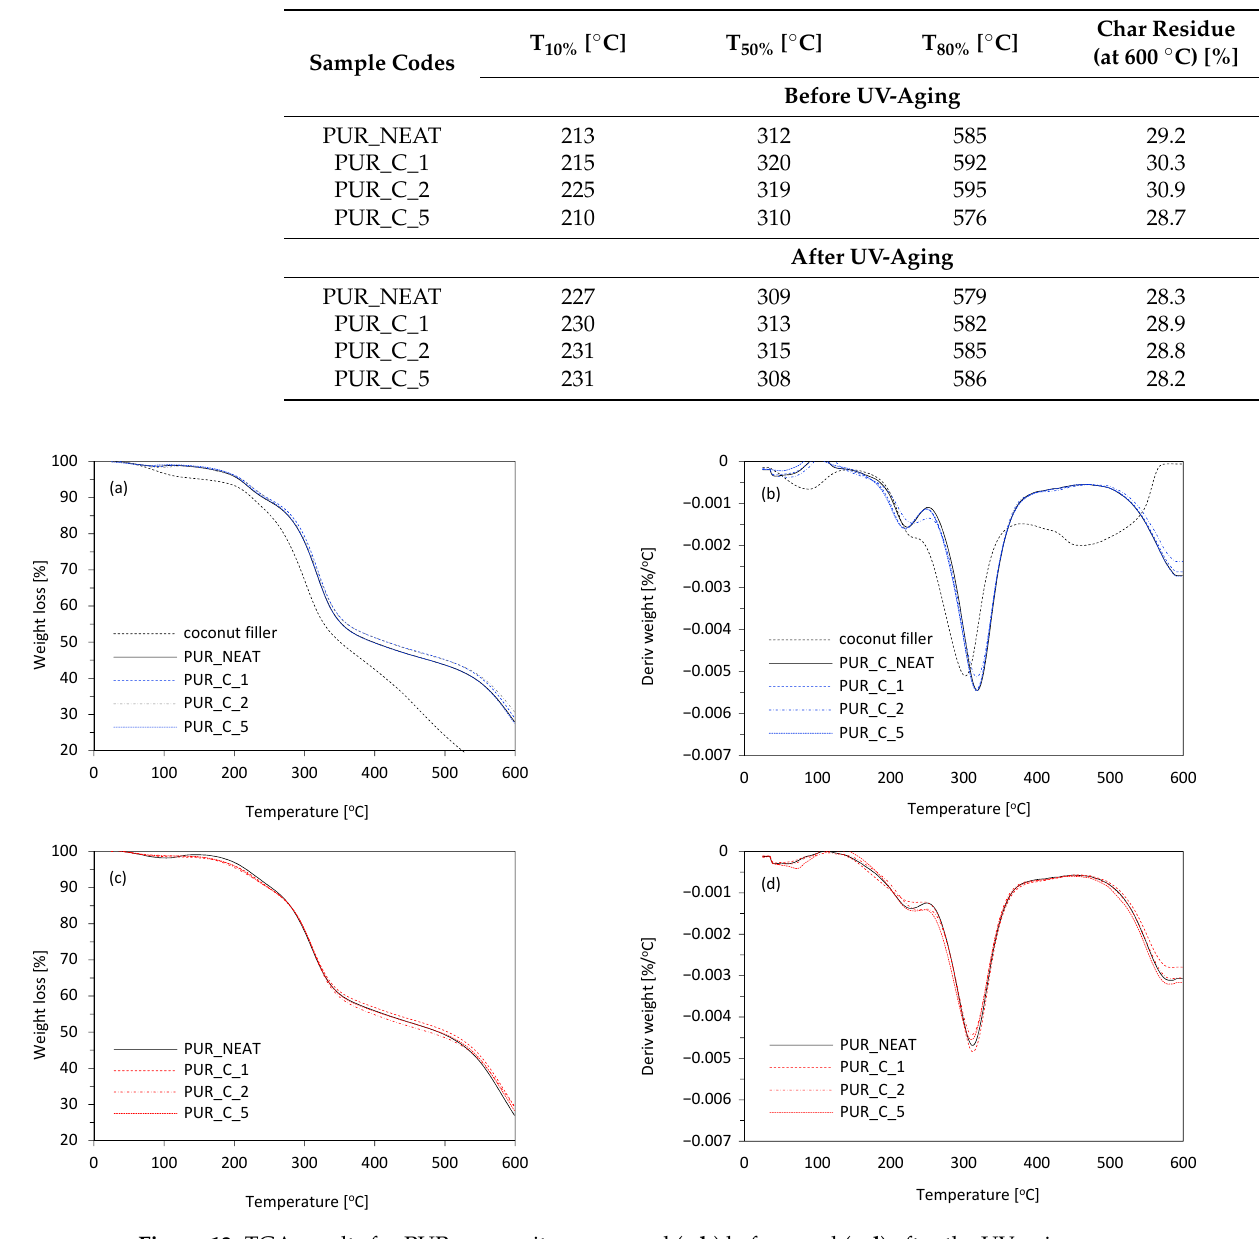
Table 4. The results of the thermogravimetric and derivative thermogravimetric analyses.